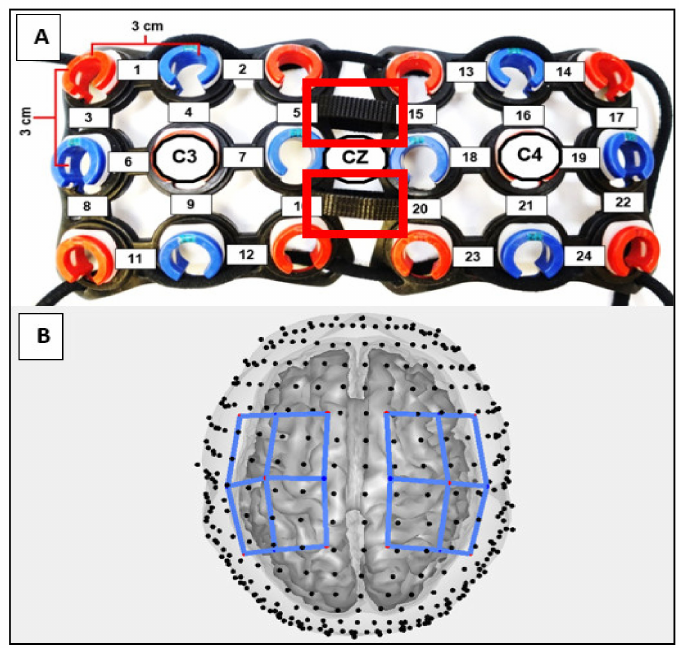
Figure 2. Adjustable headgear and channel arrangement. ( A ) Vertex (Cz) and lateral channels placed over the C3 and C4 motor cortex landmarks associated with motor activity of the hand and arm movements. Red rectangles show the adjustable Velcro straps used to accommodate different head sizes. ( B ) Visualization of headgear after virtual registration to subject brain model. Blue lines indicate placement of the headgear over the brain. M1 was defined as channels: (3–10,15–22). SMA was defined as channels: (1–5,13–17). S1 was defined as channels: